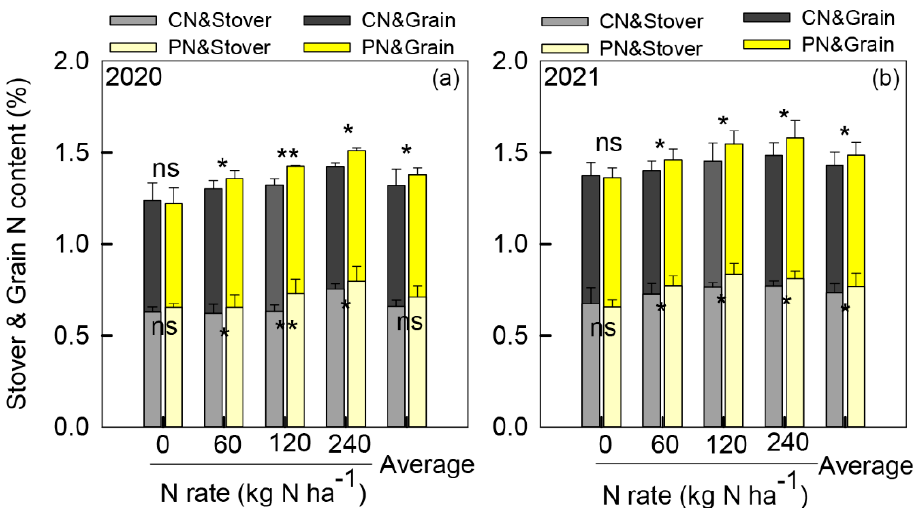
Figure 4. Sorghum stover and grain N content at the physiological maturity stage at 0 − 240 kg ha − 1 nitrogen rates under control treatment (CN) and polyaspartic acid-coated urea (PN) in 2020 ( a ) and 2021 ( b ). * and ** represent significant differences between CN and PN at the same N rate at the 0.05 and 0.01 levels, respectively, and ns represents no significant difference.